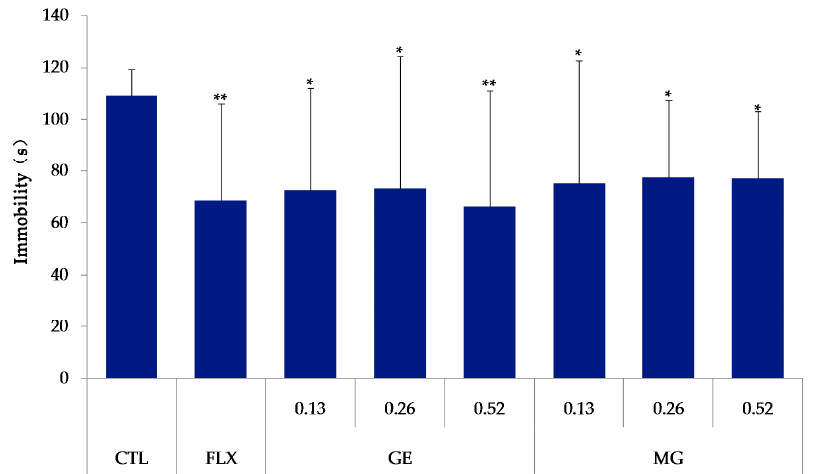
Figure 5. Effects of GE or MG on immobility time in the tail suspension test. The mice were treated orally with MG and GE at 0.13, 0.26, or 0.52 mmol/kg/day, and fluoxetine (FLX) at 20 mg/kg/day for 7 days. The bars indicate the mean ± SD ( n = 10). * p < 0.05, ** p < 0.01 compared with the control group (CTL).